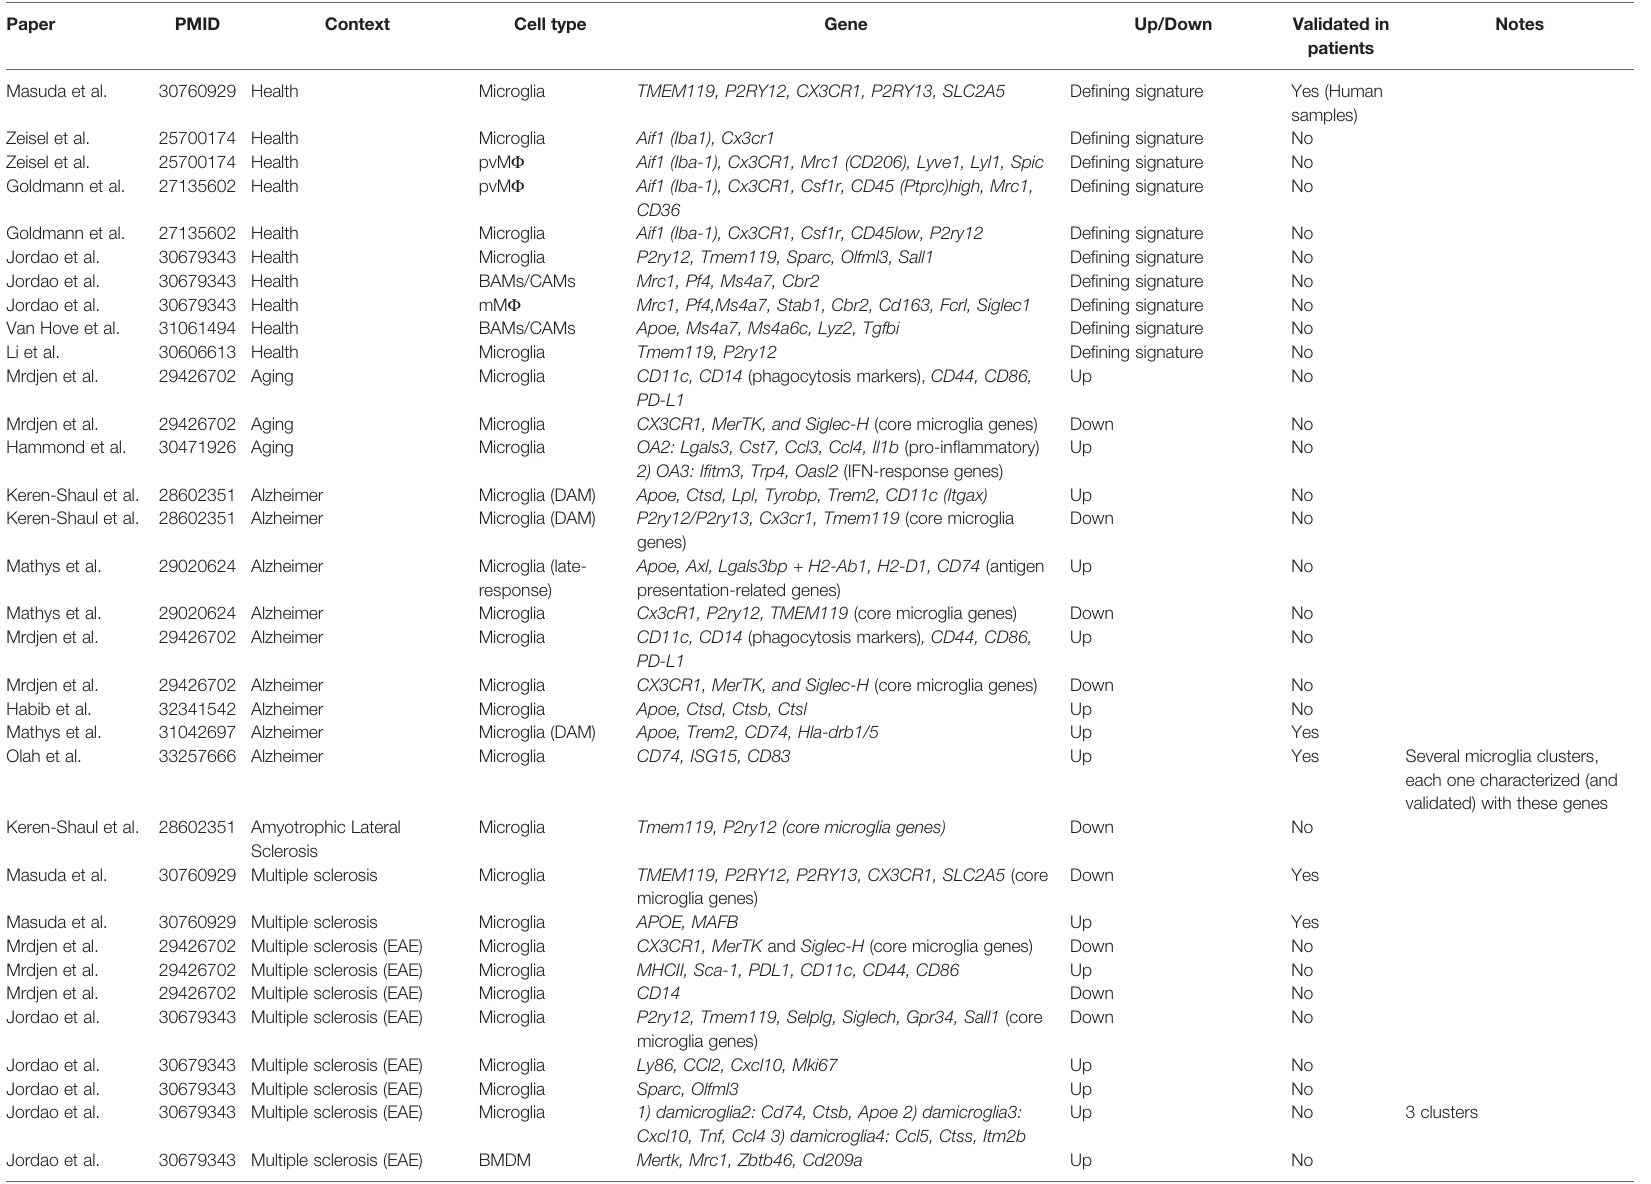
TABLE 1 | Key signatures and markers found in microglia/macrophages, T cells, astrocytes and endothelial cells subpopulations within the brain in preclinical models and/or patients of brain disorders and primary and secondary brain tumors.